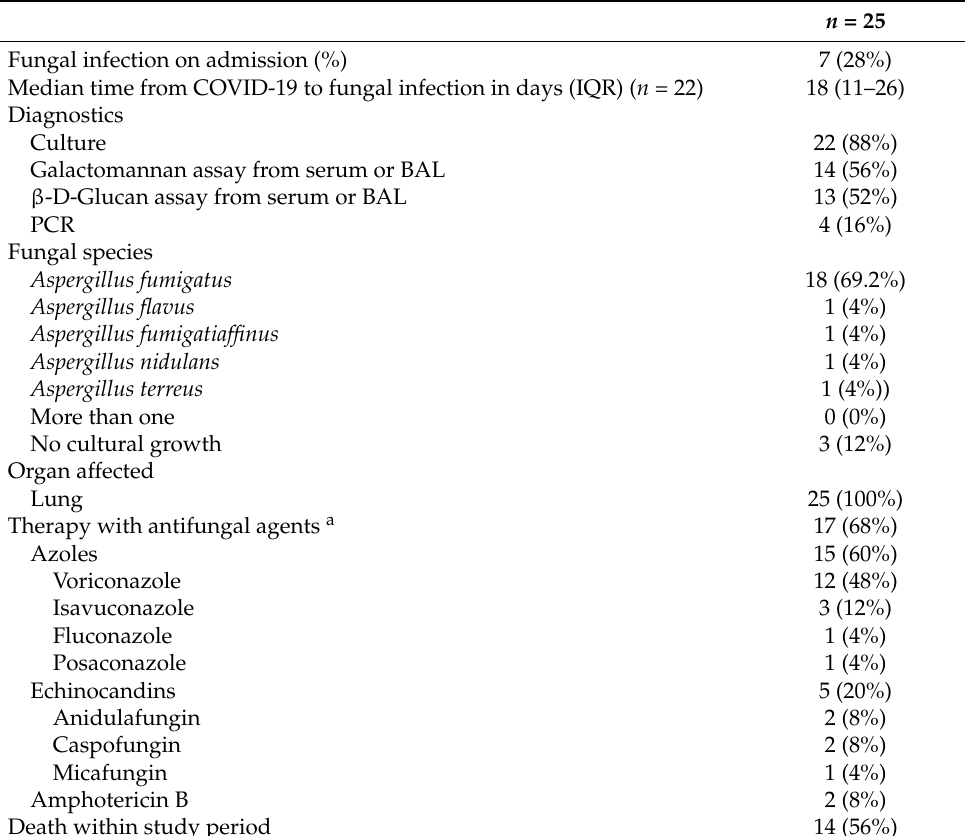
Table 5. Characteristics